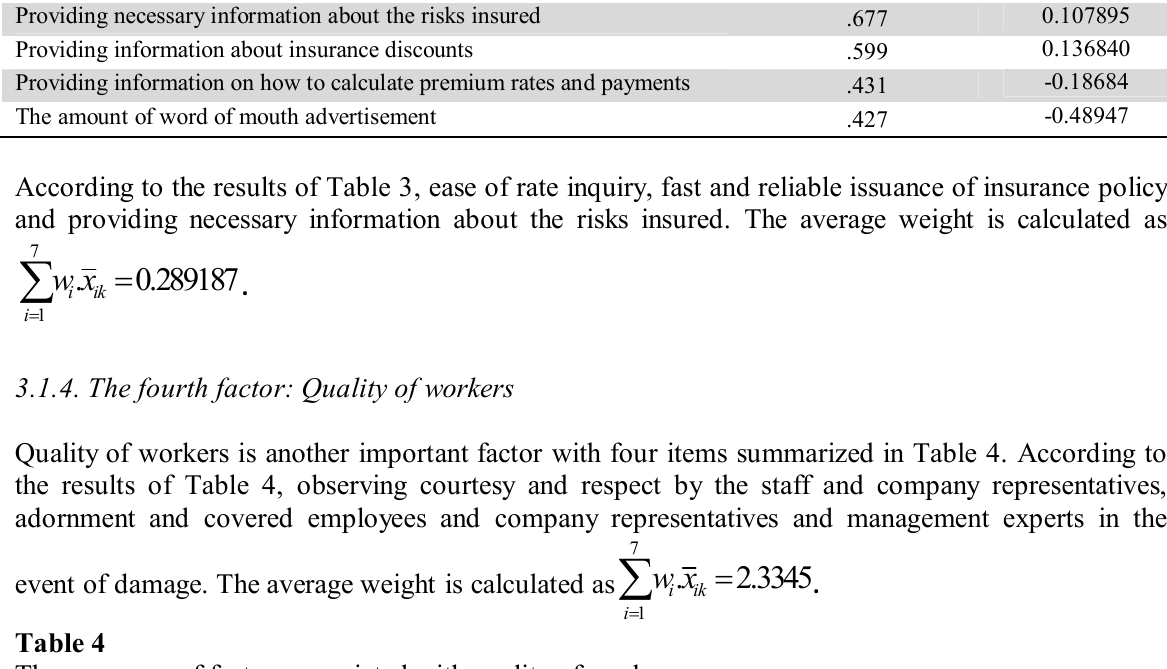
The summary of factors associated with quality of workers Option W X Observing courtesy and respect by the staff and company representatives .866 Adornment and covered employees and company representatives